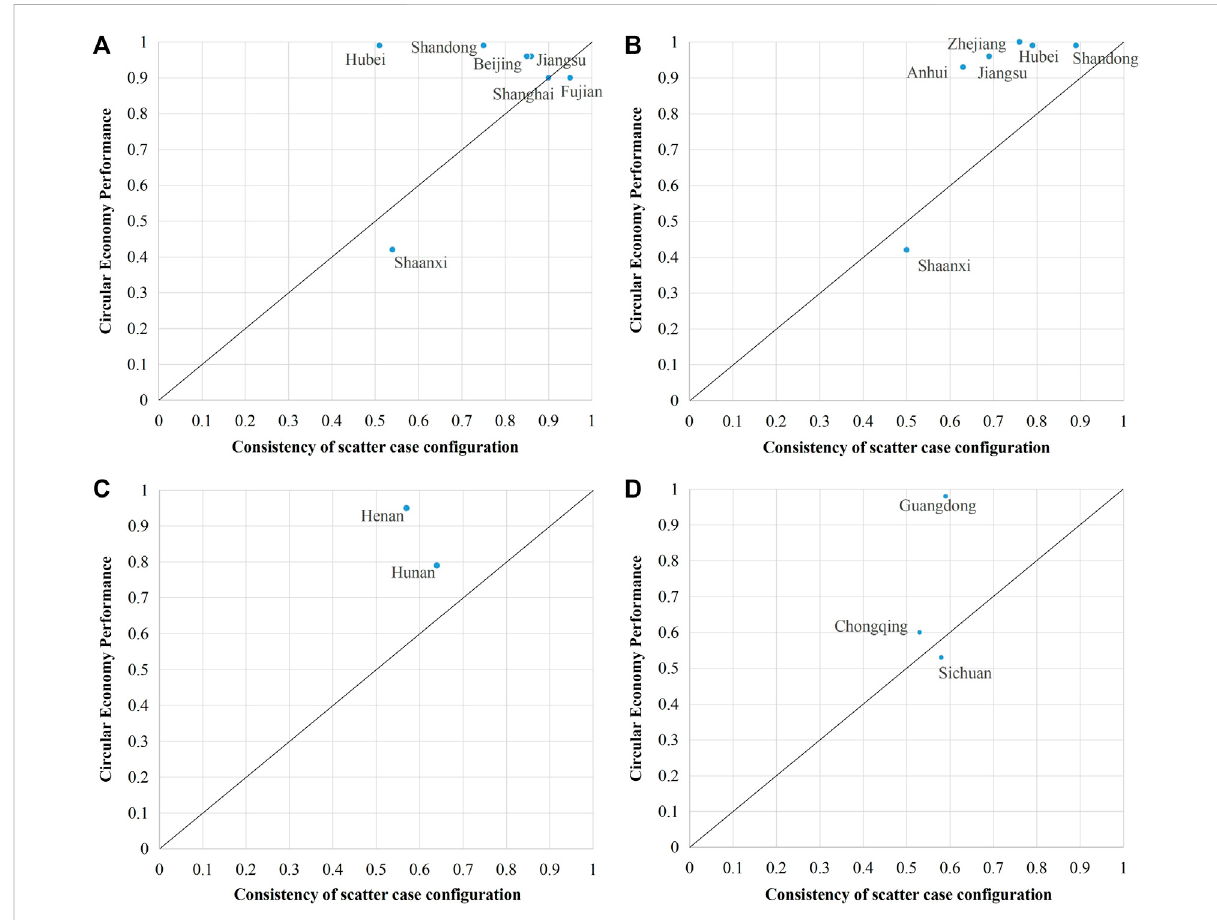
FIGURE 4 Scatterplotofhigh-levelcirculareconomyperformancecon fi gurationcases: (A) Con fi guration1, (B) Con fi guration2, (C) Con fi guration3and5, (D) Con fi guration